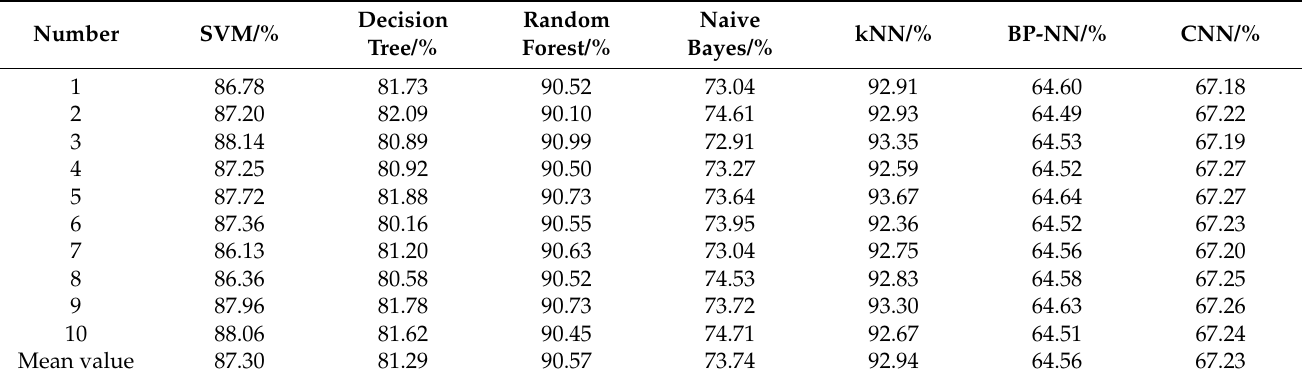
Table 6. Classification accuracies achieved by seven classification algorithms.